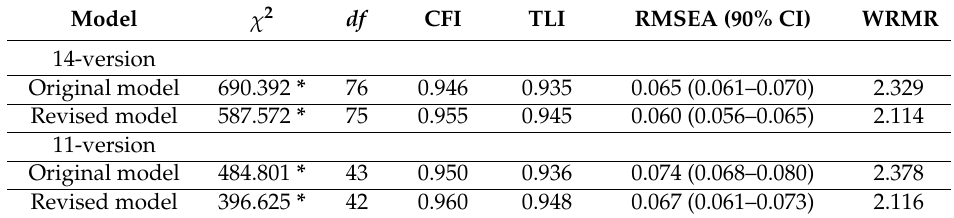
Table 2. The two-factor models of confirmatory factor analysis (CFA) for the two version.